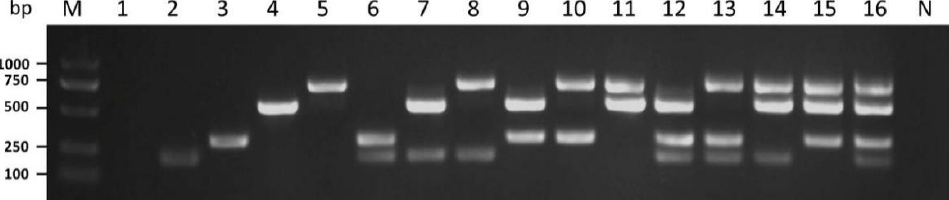
Figure 3. Specificity testing of multiplex PCR with single or mixed templates. Lane 1 shows the empty vector. Lanes 2–16 indicate the plasmids containing genome sequences of the PoV1, POSV, OMIV, OMSV, POSV + PoV1, PoV1+ OMIV, PoV1 + OMSV, POSV + OMIV, POSV + OMSV, OMIV + OMSV, PoV1 + POSV + OMIV; PoV1+ POSV+ OMSV, PoV1 + OMIV + OMSV, POSV + OMIV + OMSV, PoV1 + POSV+ OMIV + OMSV as templates, respectively. N, negative control, the healthy P. ostreatus sample. Lane M: GL DNA Marker2000.